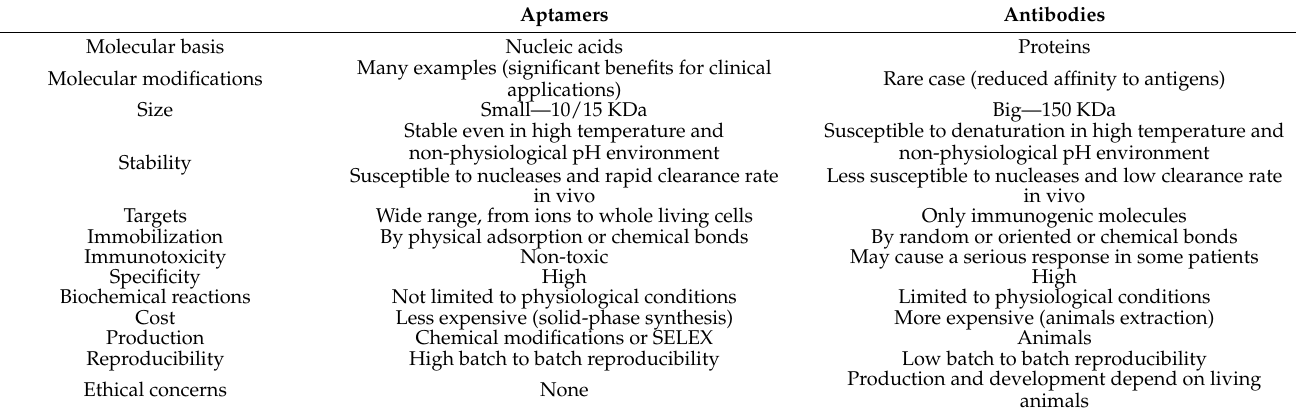
Table 1. Aptamers versus